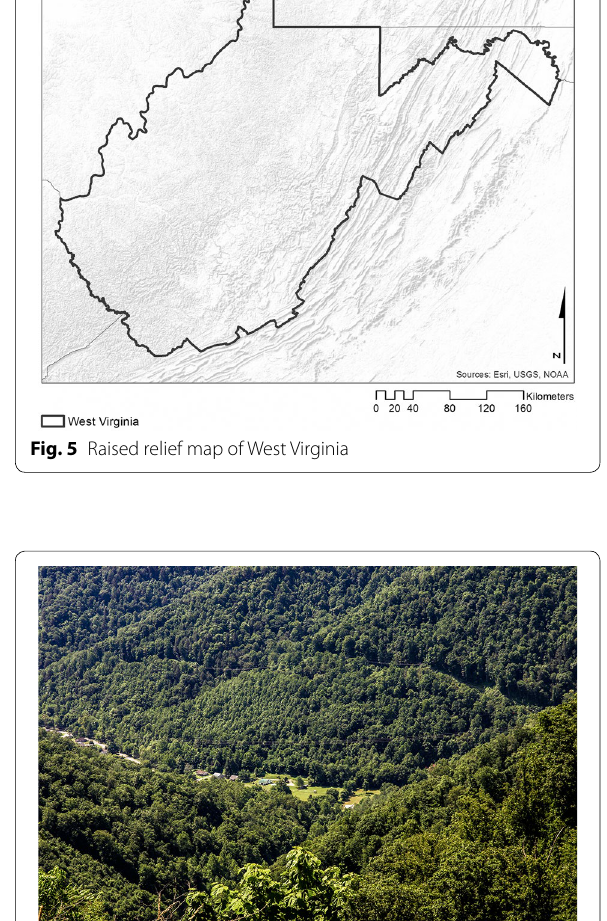
Fig. 6 Typical small settlement on valley floors. Photo: Vincenzo Cribari